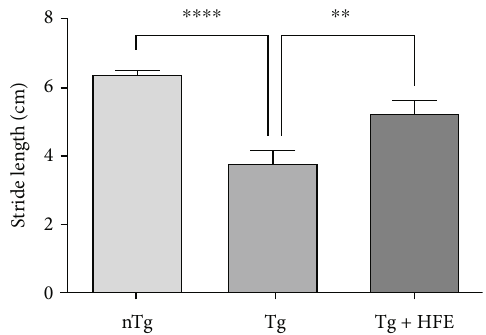
Figure 2: Herbal formula extract (HFE) attenuated motor function impairment. Tg mice showed decreased stride length compared with nTg mice. However, HFE treatment inhibited motor function defects in hSOD1 G93A mice. Data are presented as the mean ± SEM. n =7 mice per group. ∗∗ p < 0 : 01 , ∗∗∗∗ p < 0 : 0001 . nTg: nontransgenic mice, Tg: transgenic mice, Tg +HFE: HFE- treated transgenic